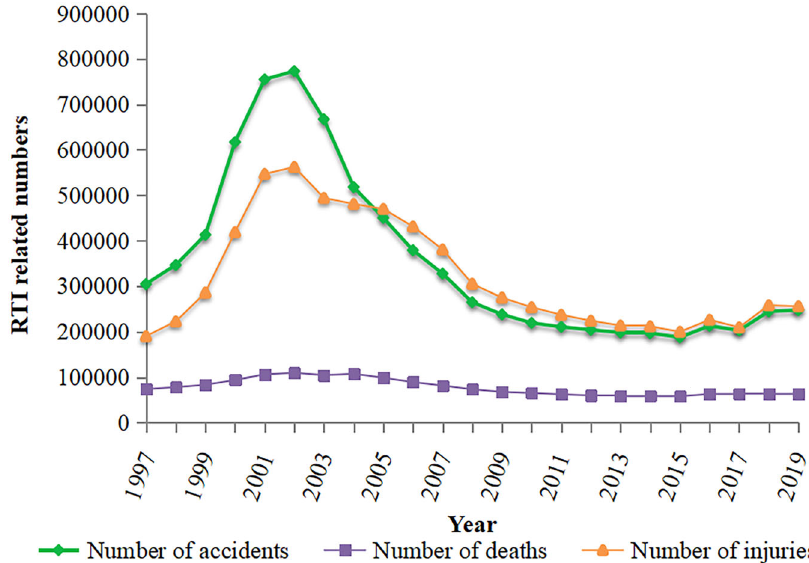
Fig. 2 Trends in the number of road traf fi c injures in China from 1997-2019.